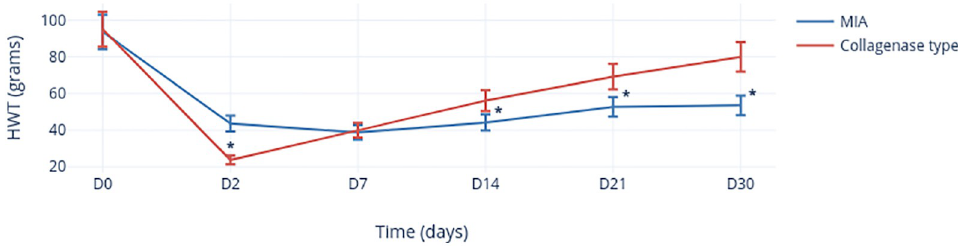
Fig 6. Change in the HWT after MIA (blue) or Col-2 (red) injection as a function of time. Values are the mean ± SD and were analyzed using the Mann–Whitney test. � Significant